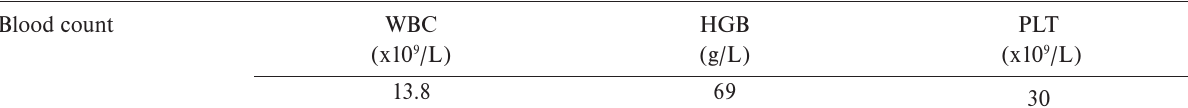
Table 1. Laboratory values at diagnosis.